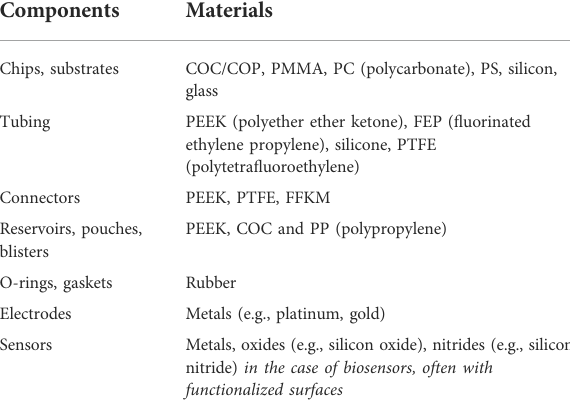
TABLE 2 Commonly used materials in micro fl uidics [Adapted from (The Micro fl uidics Association, 2015)].